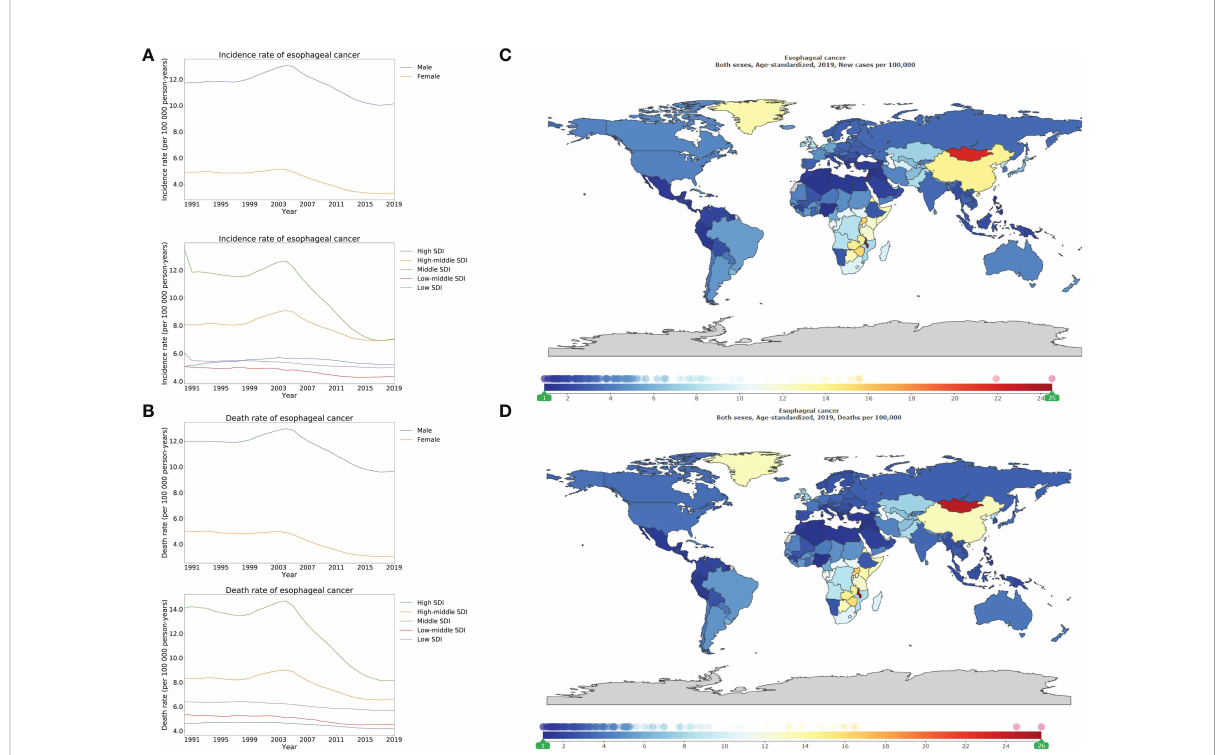
FIGURE 4 Burden of esophageal cancer for 204 countries and territories. Age-standardized incidence (A) and death (B) rate per 100000 population of esophageal cancer from 1990 through 2019 by country and territory, strati fi ed by sex or SDI; age-standardized incidence (C) and death (D) rate of esophageal cancer per 100000 person-years by country and territory, in 2019. The maps in (C) and (D) were generated by GBD 2019